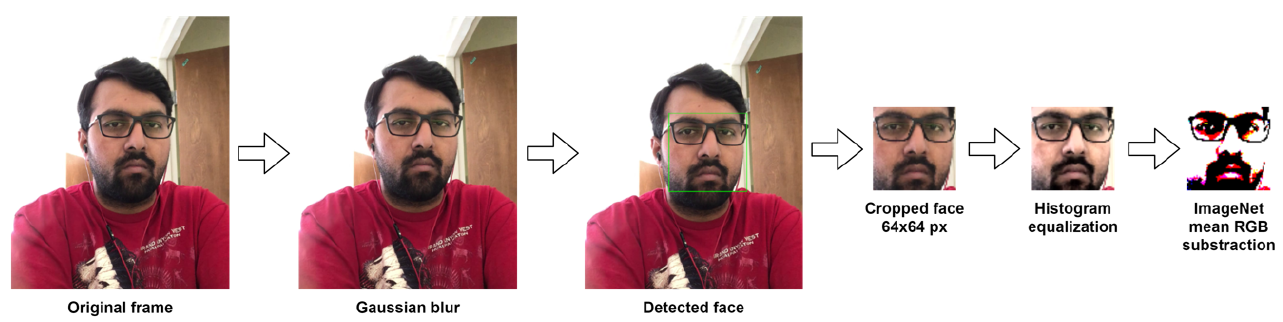
Figure 3. Preprocessing of the driver’s face.